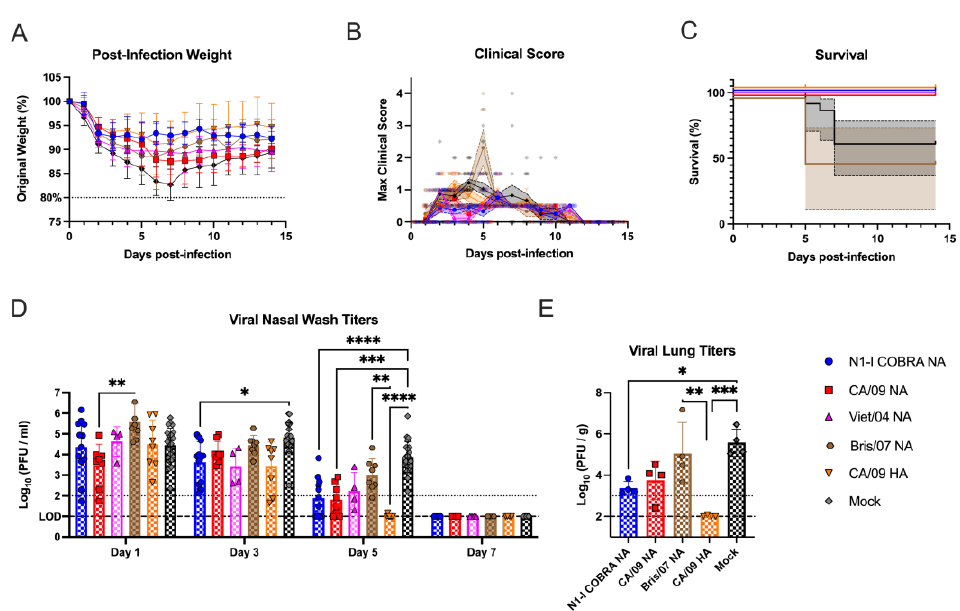
Figure 2. N1-I COBRA NA vaccines performed similarly to CA/09 HA and NA vaccines in the naïve ferret model intranasally challenged with CA/09 H1N1. ( A ) After infection with CA/09, the weight during the challenge was normalized to the percentage of the original starting weight before infection. ( B ) The maximum clinical scores from the morning and evening checks were displayed with a score of three or greater indicating clinical endpoint. Individual ferret clinical scores are shown with the line connecting the mean score and the range of the standard error of the mean shaded. ( C ) Survival was determined after accounting for censored histopathology ferrets purposefully euthanized on day 5 p.i. The 95% asymmetrical confidence intervals are shown as shadow for the groups that did not have 100% survival. ( D ) The viral nasal wash titers for all vaccinated groups were determined through plaque assay and analyzed with a mixed effects model. ( E ) The viral lung titers were quantified by plaquing the homogenized tissue from both the upper and lower left lung lobes. The lobe location was not a significant factor, and, thus, the titers were analyzed with a one-way ANOVA. Viral lung titers were not harvested for the Viet/04 NA group. The limit of detection (LOD; dashed line) was 1.0 log 10 (PFU/mL) and 2.0 log 10 (PFU/g) for the nasal wash titers and lung titers, respectively. The limit of quantification (dotted line) was 2.0 log 10 (PFU/mL) and 3.0 log 10 (PFU/g) for the nasal wash titers and lung titers, respectively. Tukey’s test for multiple comparisons was used for viral titer comparisons. All error bars represent standard deviation. The minimum weight before clinical endpoint was 75%, with 80% denoting an increase in clinical scoring. Adjusted p -value: * ≤ 0.05, ** ≤ 0.01, *** ≤ 0.001, **** ≤